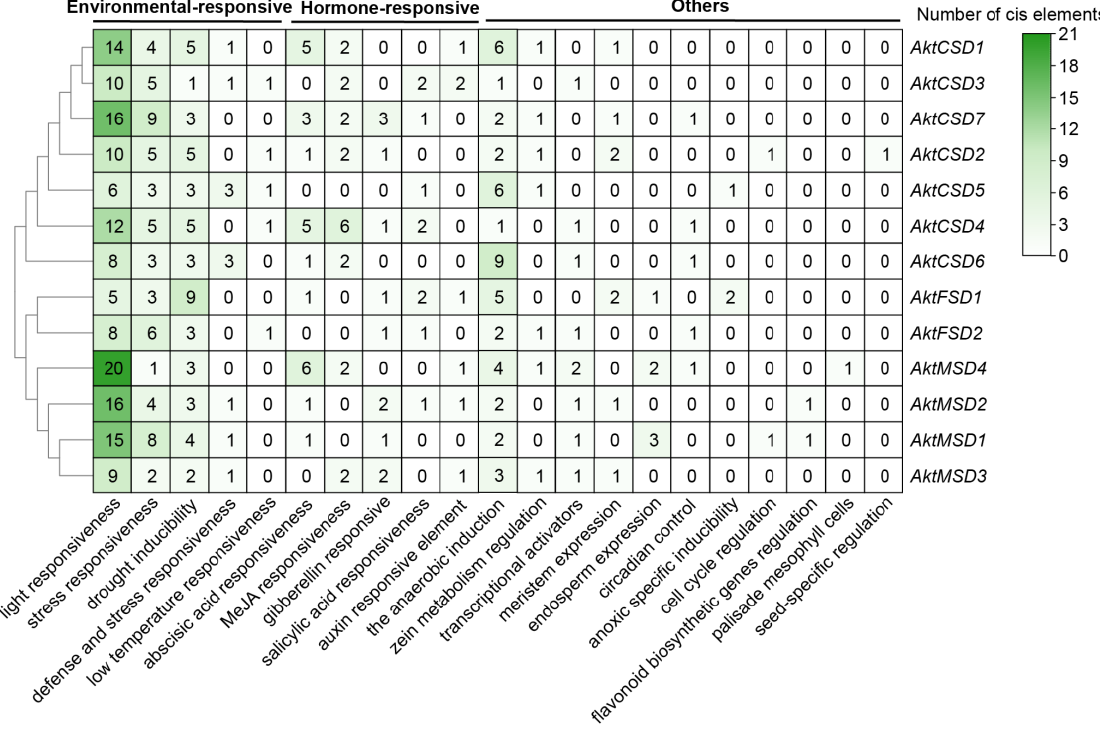
Figure 4. Analysis of cis-regulatory elements in the 2 kb region upstream of the transcription start site of AktSODs .